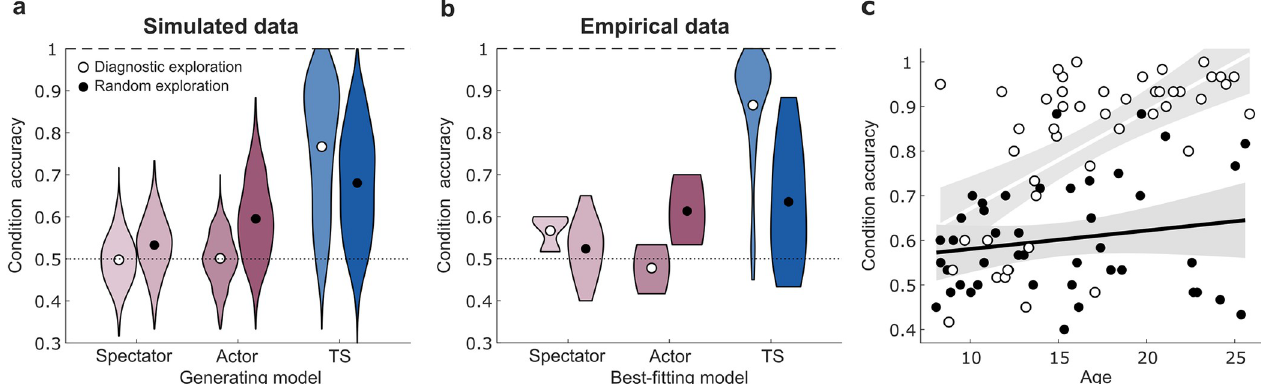
Fig 4. Simulated and empirical data for condition prediction accuracy as a function of diagnostic interventions. (a) Simulations reveal that consistently selecting the diagnostic exploratory choice is only beneficial for the Task Set (TS) model. Random exploration yields better controllability assessments for all other models. (b) A median-split of participants based on their proportion of diagnostic interventions closely matches model predictions and shows a unique performance benefit of diagnostic choices for individuals best fit by the Task Set model. Given that only two participants were best fit by the Learned Transition Structure model, it was not included in these analyses. (c) A median-split analysis revealed that age-related improvements in condition prediction accuracy were driven largely by participants who made more diagnostic choices (open circles) whereas no significant age-related improvement was evident for participants who explored more randomly (filled circles). Shaded areas represent 95% confidence intervals. Abbreviations: TS: Task Set.